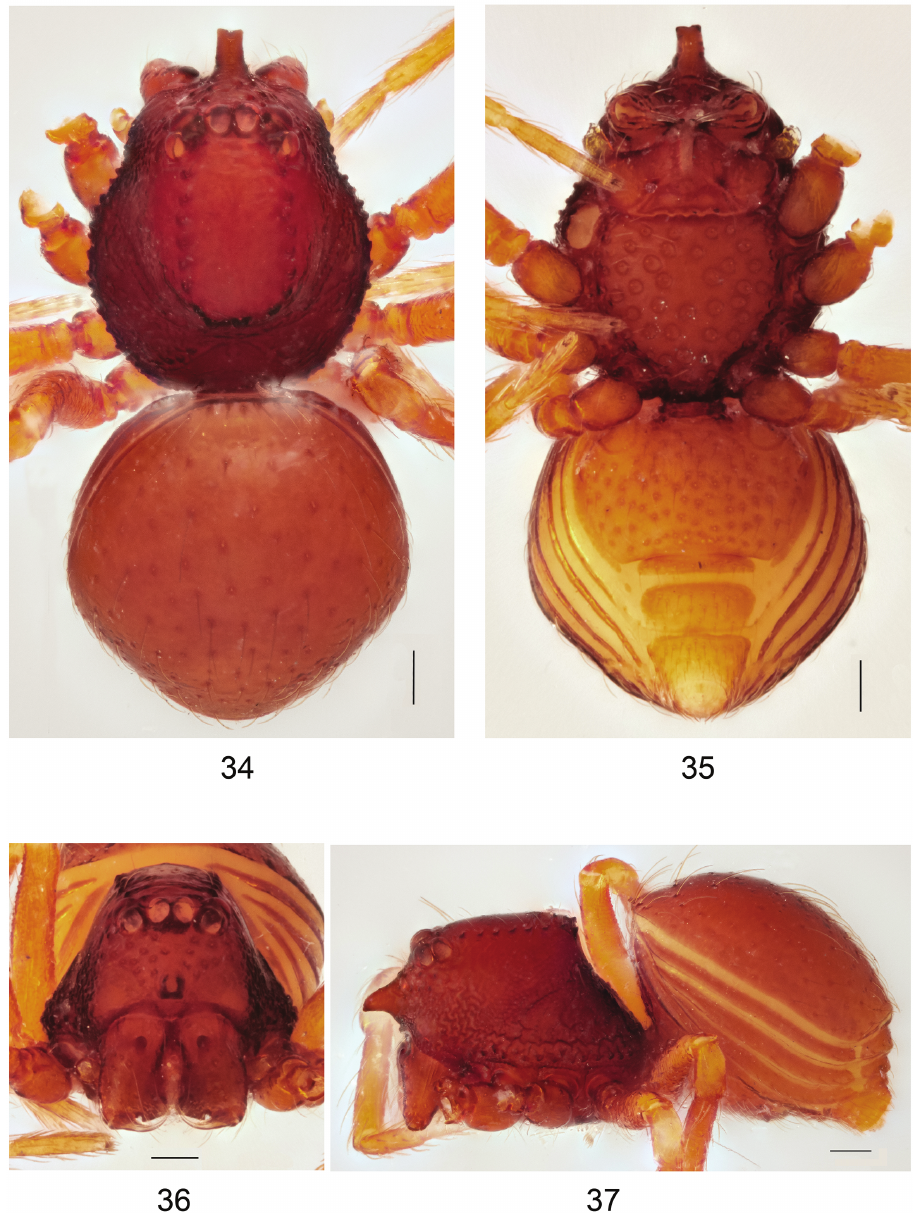
Figures 34–37. Brignoliella patmae sp. n., male. 34 Habitus, dorsal view. 35 Habitus, ventral view. 36 Carapace, frontal view. 37 Habitus, lateral view. Scale bar: 1.0